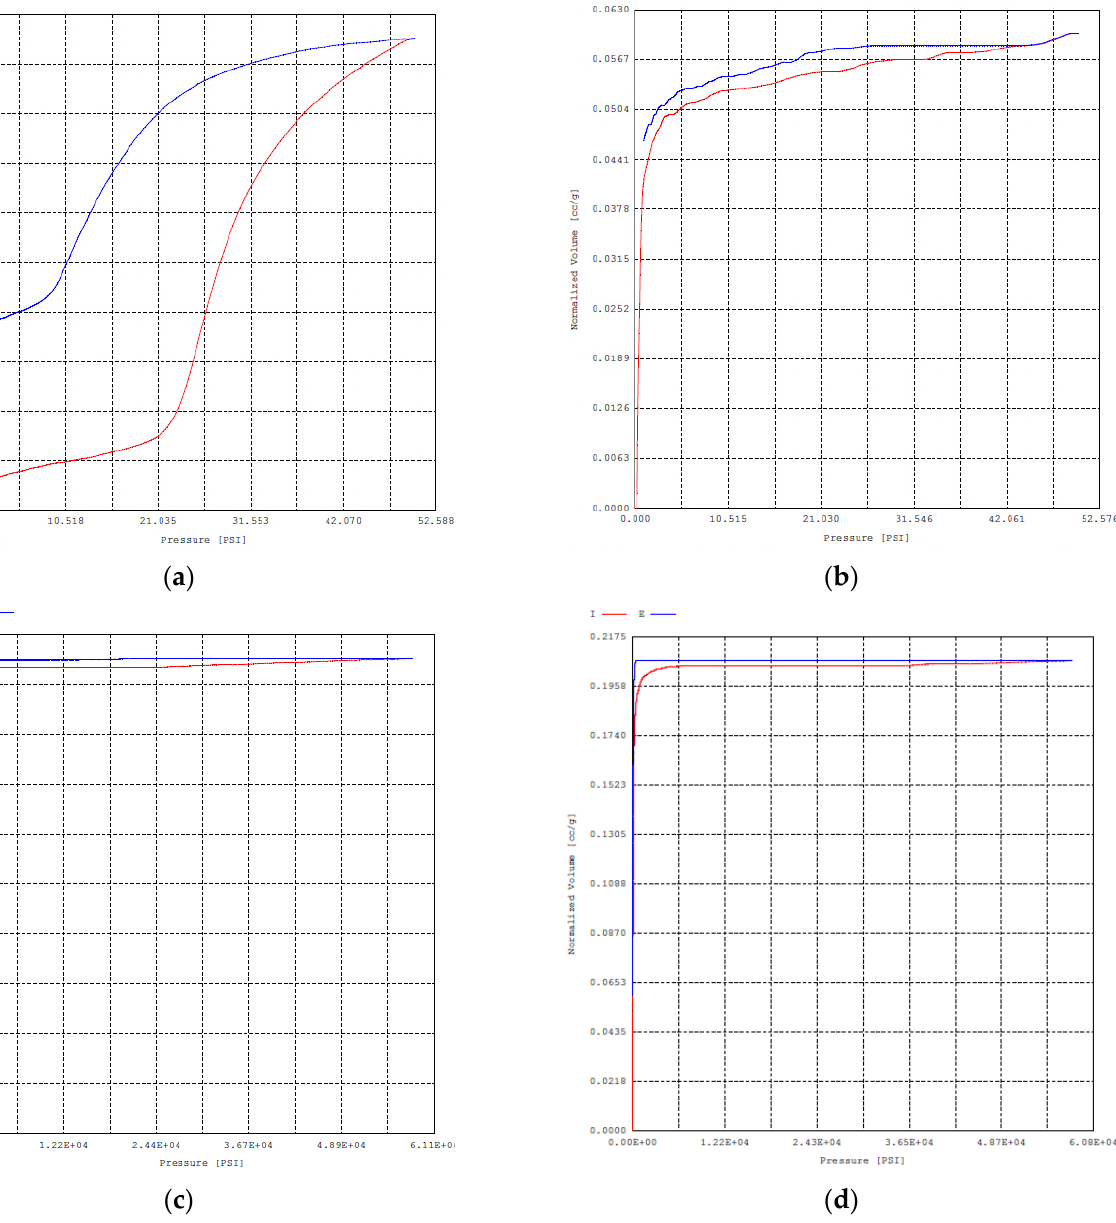
Figure 11. The normalized volume of mercury vs. pressure (low and high). Intraparticle porosity is shown in red and interparticle one in blue: ( a ) Reference at low pressure; ( b ) MBC-0.4 at low pressure; ( c ) Reference at high pressure; ( d ) MBC-0.4 at high pressure.